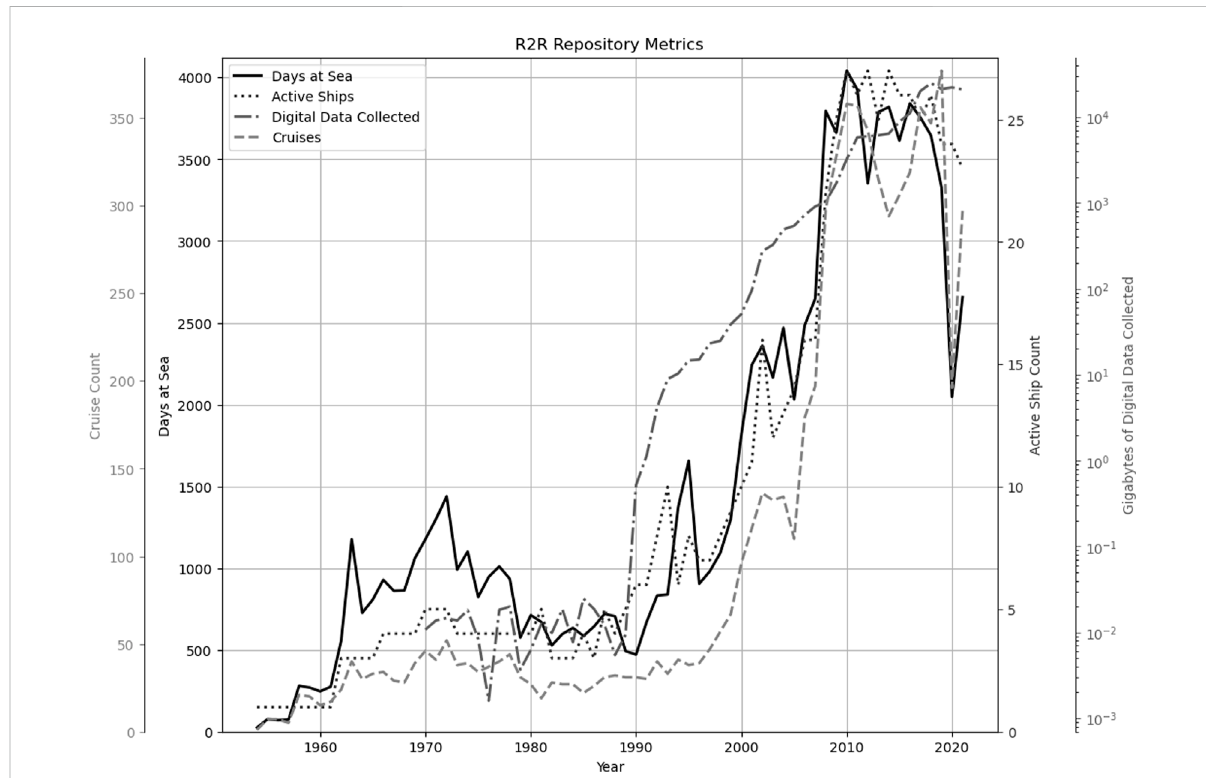
FIGURE 1 Ship,cruise,daysatsea,anddatametricsfromtheR2Rdatarepository.Note:gigabytesofdigitaldataacquiredarerepresentedaslogscale.The downtrend in 2020 and 2021 are due to the impact of the COVID-19